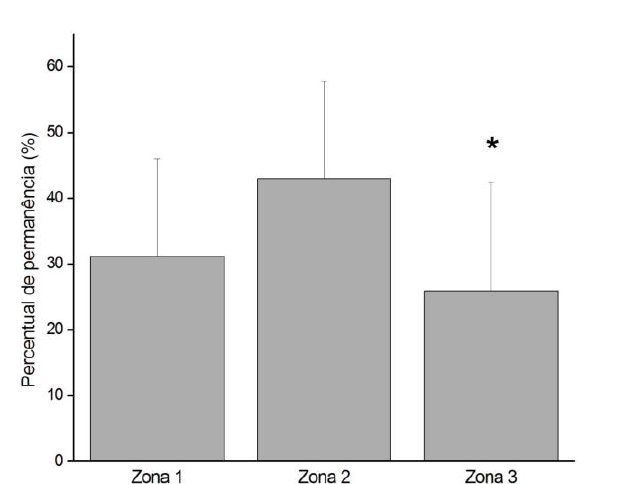
Figura 1. Percentual de permanência (%) em cada zona de frequência cardíaca. *Diferença significativa de z2